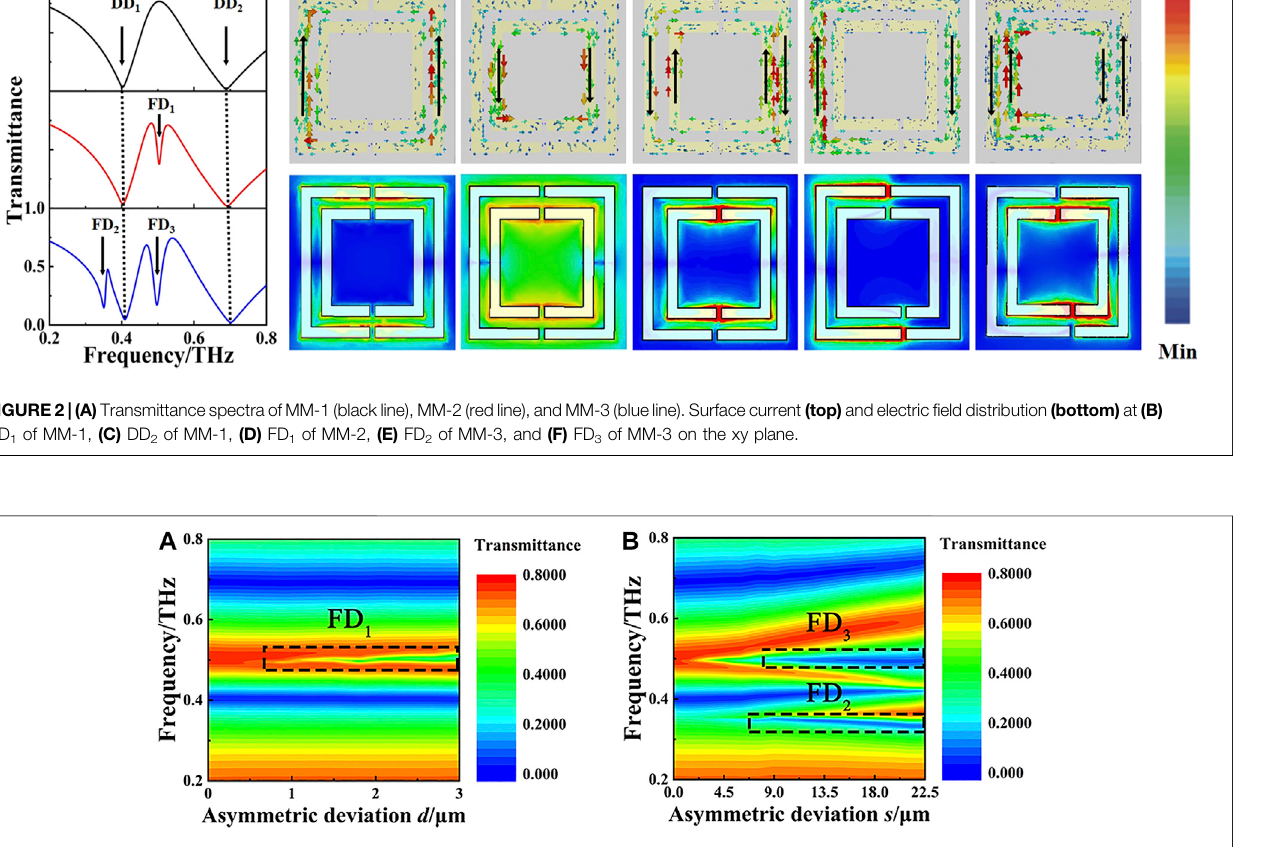
FIGURE 3 | Two-dimensional diagram of transmittance as a function of frequency and asymmetric deviation for (A) FD 1 of MM-2 and (B) FD 2 and FD 3 of MM-3.